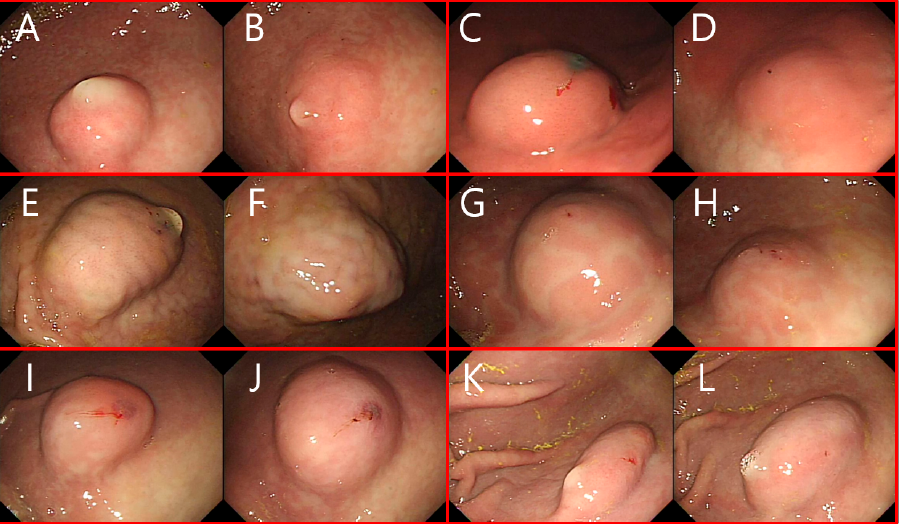
Figure 6. The SFC maintained by several submucosal injection agents right after injection (left side in each group; ( A , C , E , G , I , K )) and 30 min after injection (right side in each group; ( B , D , F , H , J , L )): ( A , B ) normal saline, ( C , D ) Eleview, ( E , F ) Blue Eye, ( G , H ) CS/ β -GP 12%, ( I , J ) CS/ β -GP 20%, and ( K , L ) CS/ β -GP 28%.